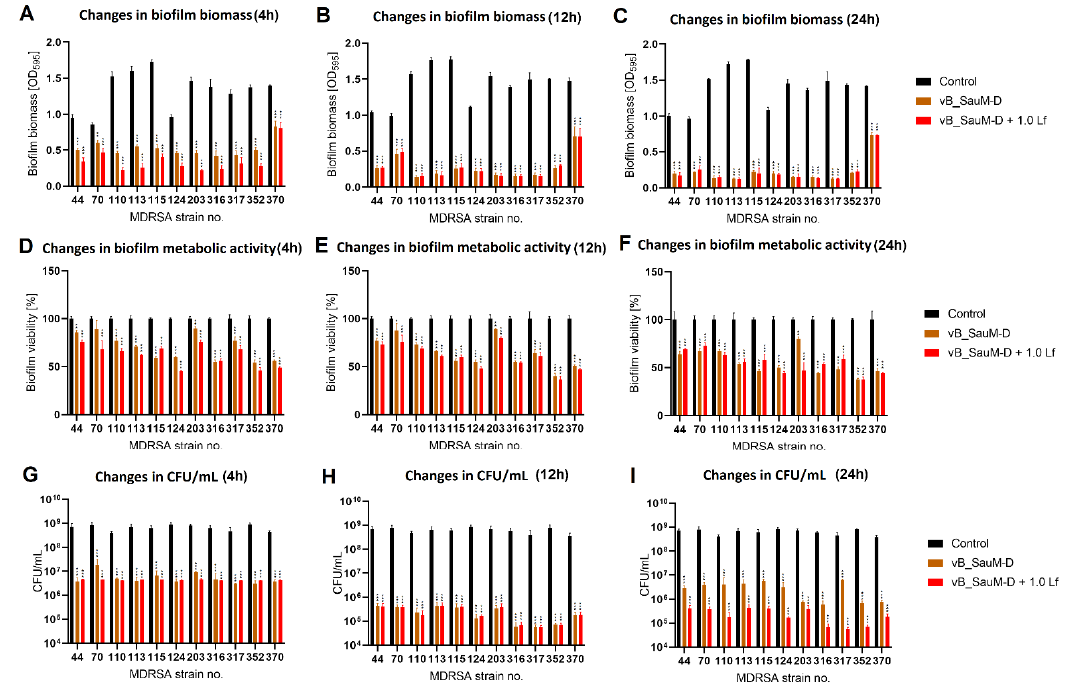
Figure 7. Influence of phage vB_SauM-D and vB_SauM-D+ 1.0 mg/mL lactoferrin (Lf) on